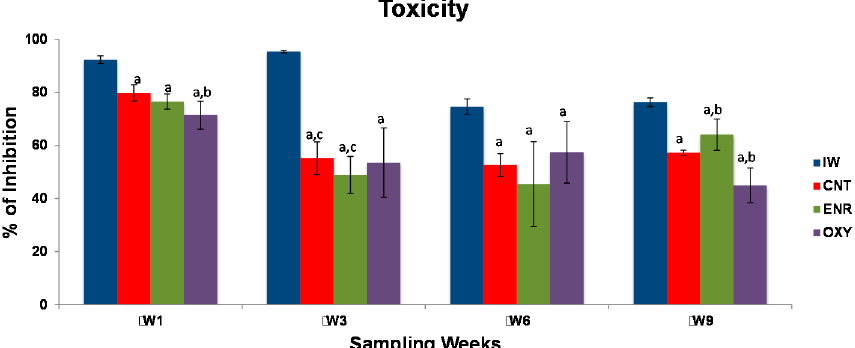
Figure 5. Toxicity based on bacterial luminescence expressed in percent of inhibition of bacterial activity from toxic organic compounds, along the sampled weeks. Wastewater not doped (CNT) or doped with the antibiotic enrofloxacin (ENR) or oxytetracycline (OXY). a: Significant differences ( p < 0.05) compared to the initial wastewater (IW); b: Significant differences ( p < 0.05) compared to the control (CNT); c: Significant differences ( p < 0.05) compared to the same treatment the week before.